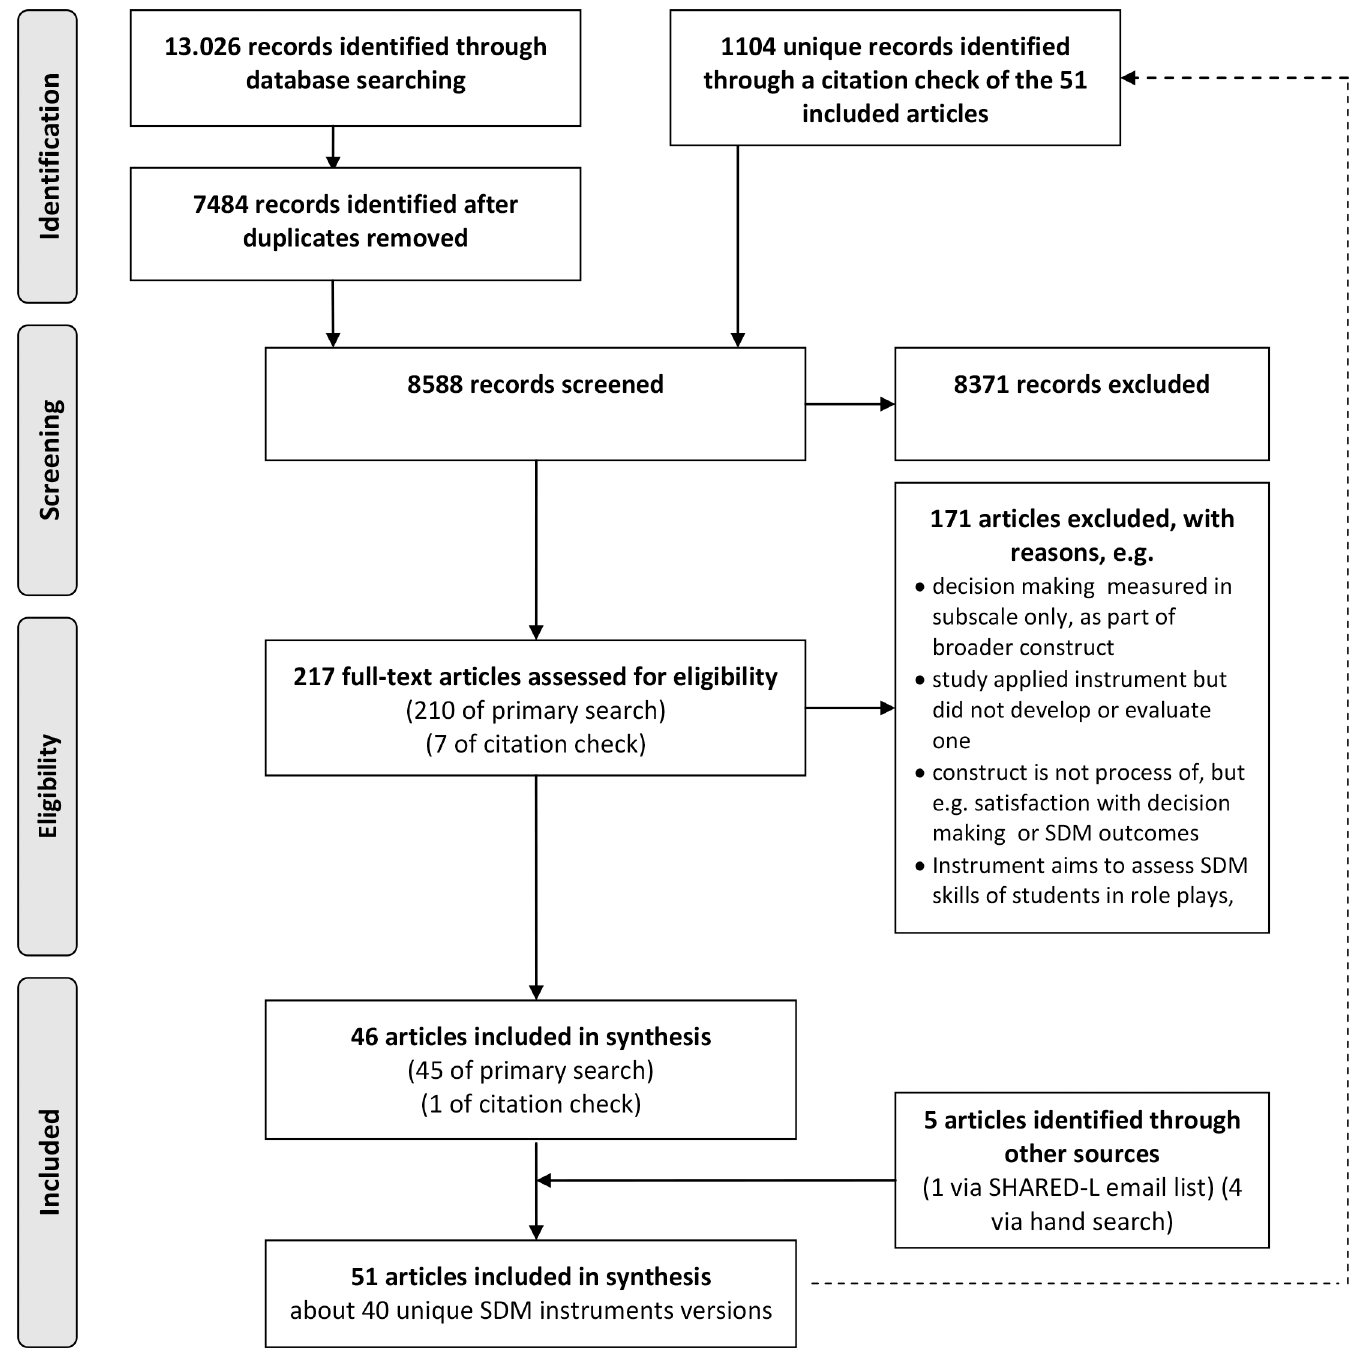
Fig 1. Flow diagram of article selection